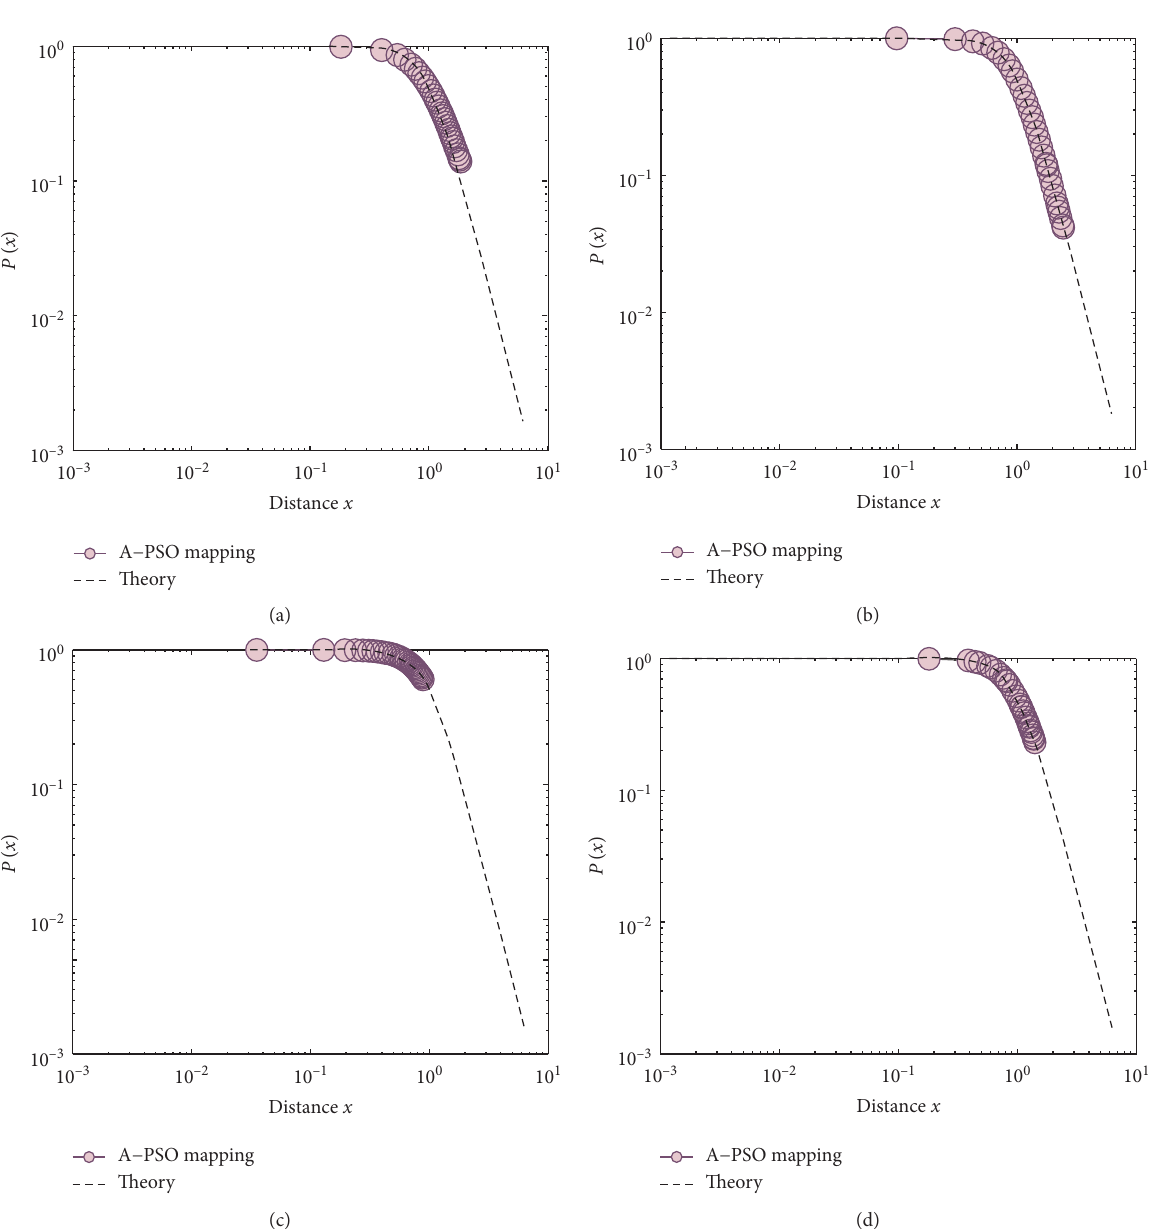
Figure 3: Empirical versus theoretical connection probability. The hyperbolic embedding of directed networks is successful, as the empirical connection probability closely matches the geometric hidden model prediction. (a–d) The results of the C. elegans neural network, in- ternational trade network, email network, and international migration network, respectively. The black dashed lines are theoretical results of the connection probability, given by p ( x ) � ( 1 + x β ) − 1 . Note that the parameters used in the theoretical simulation are the same as the corresponding empirical network. The pink dots are results of the empirical directed analysis. The whole range of hyperbolic distances and connection probabilities are binned, and each bin is the average of the values in